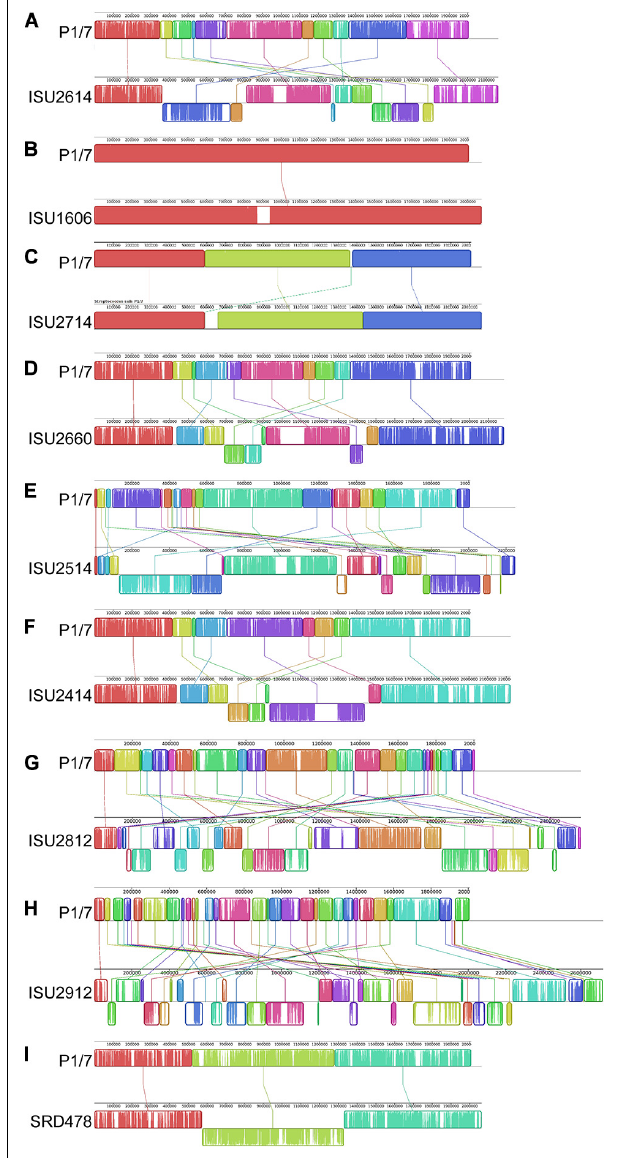
FIGURE 3 | Comparison of the linear organization of S. suis chromosomes. Linear comparison of each closed S. suis genome to P1/7 (top), reference sequence. Locally collinear blocks (LCBs) representing regions of sequence alignment are shown as colored rectangles connected by lines. LCBs placed above the center line are in the same orientation as the reference; LCBs placed below the center line are in reverse orientation. Blank sections are regions of low sequence conservation. (A) P1/7 compared to ISU2614. (B) P1/7 compared to ISU1606. (C) P1/7 compared to ISU2714. (D) P1/7 compared to ISU2660. (E) P1/7 compared to ISU2514. (F) P1/7 compared to ISU2414. (G) P1/7 compared to ISU2812. (H) P1/7 compared to ISU2912. (I) P1/7 compared to